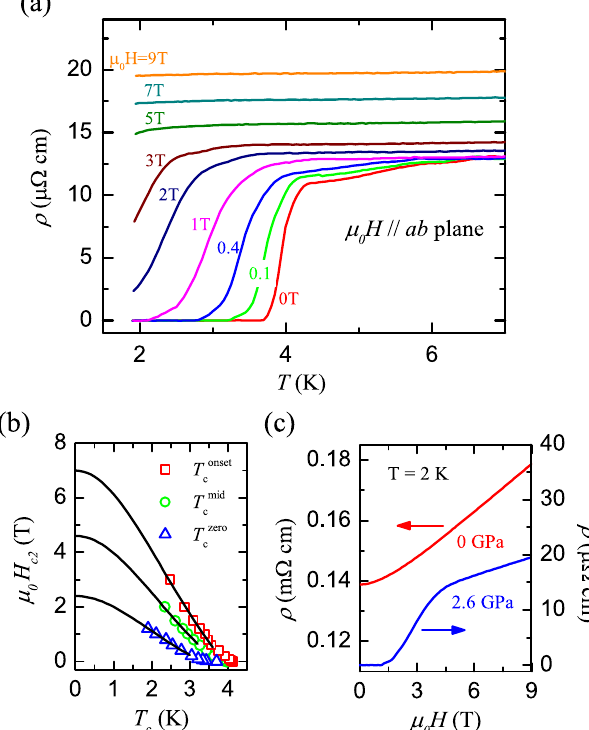
Figure 4. ( a ) Temperature dependence of the ab -plane resistivity measured at 2.6 GPa in magnetic fields up to 9 T for BaMnBi 2 crystal. ( b ) Upper critical field μ 0 H c 2 vs T c determined by using the superconducting transition temperatures in ( a ). ( c ) Magnetic field dependence of ρ measured at 2 K under ambient pressure and 2.6 GPa. The field is parallel to ab